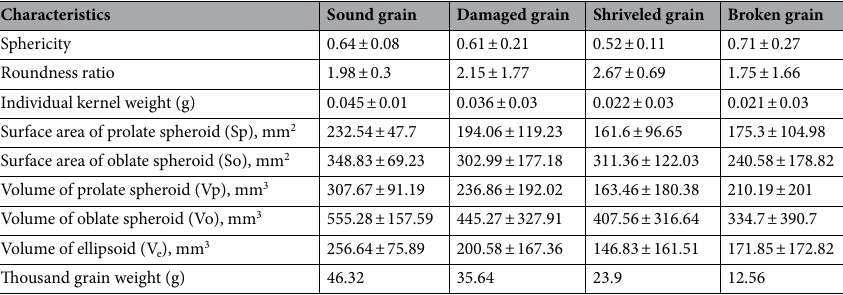
Table 6. Physical characteristics of different grain fractions of selected wheat variety (n =